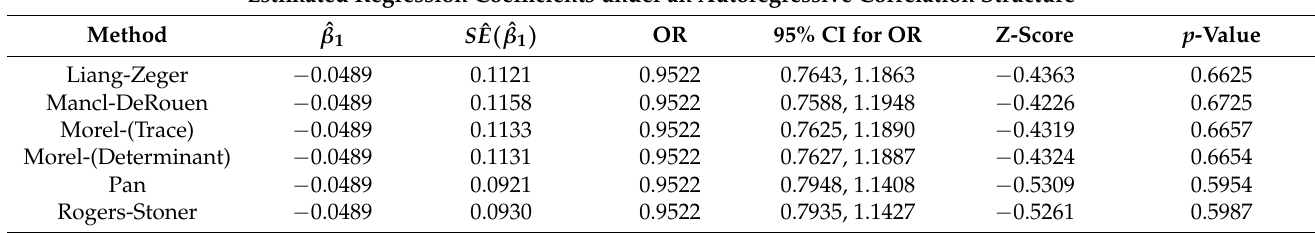
Table 4. Estimated regression coefficients, odds ratios (OR), standard errors, 95% confidence intervals (CI) from analysis of repositioning events in recorded ICU SpO 2 measurements within the first 24 h for 100 patients.